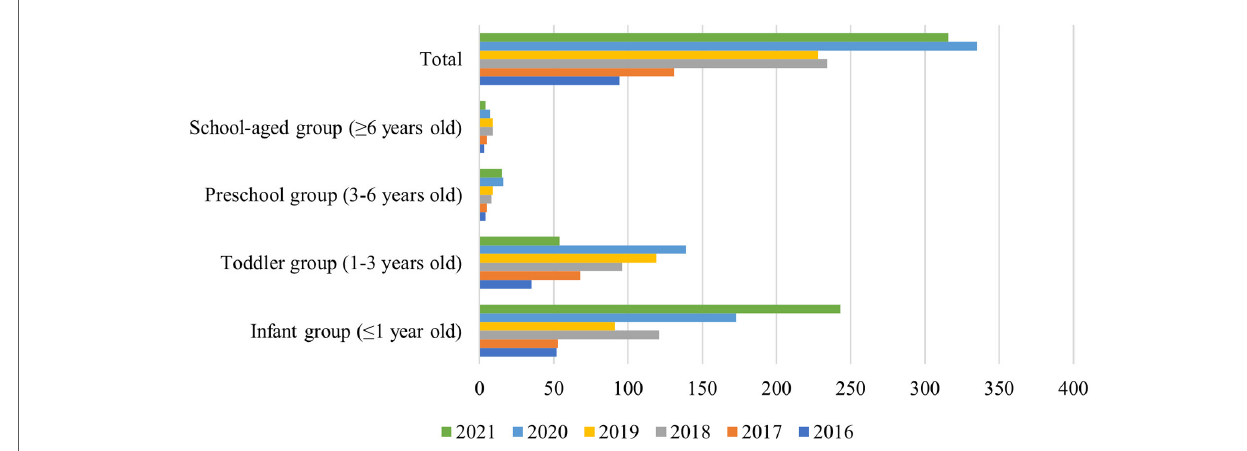
FIGURE 1 Age distribution of children with 1,338 Salmonella strains. Children are divided into four groups by age. The different bars represent different years. Age distribution of children with Salmonella infection was mostly under 3 years old.